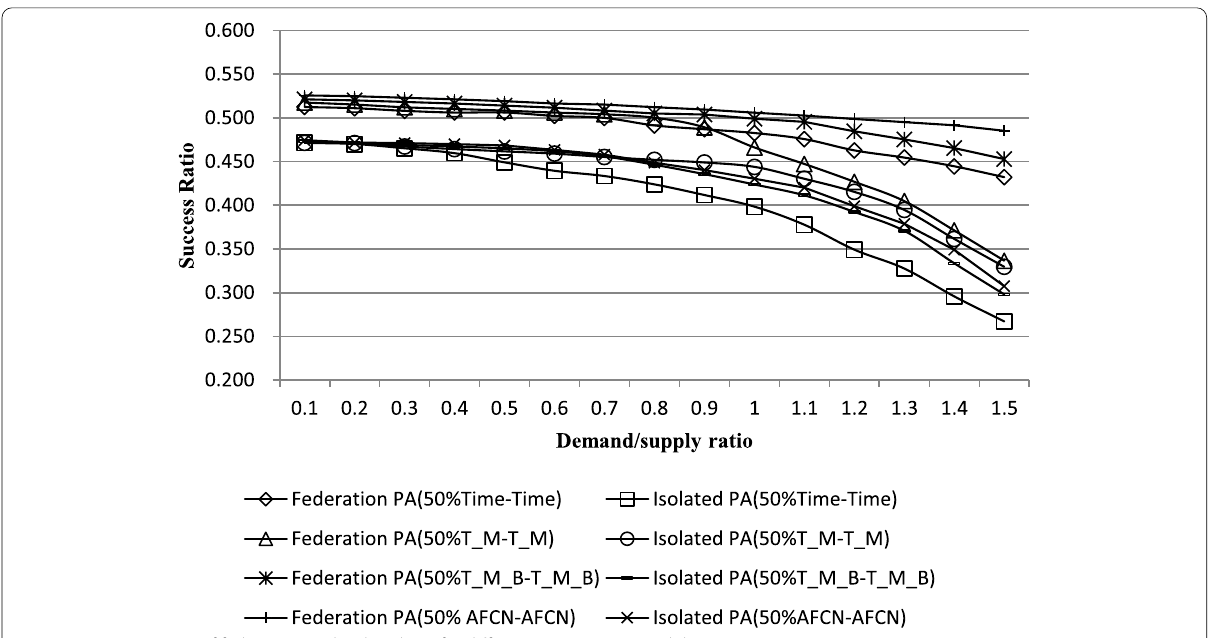
Fig. 12 Success ratios of federation and isolated PAs for different negotiation